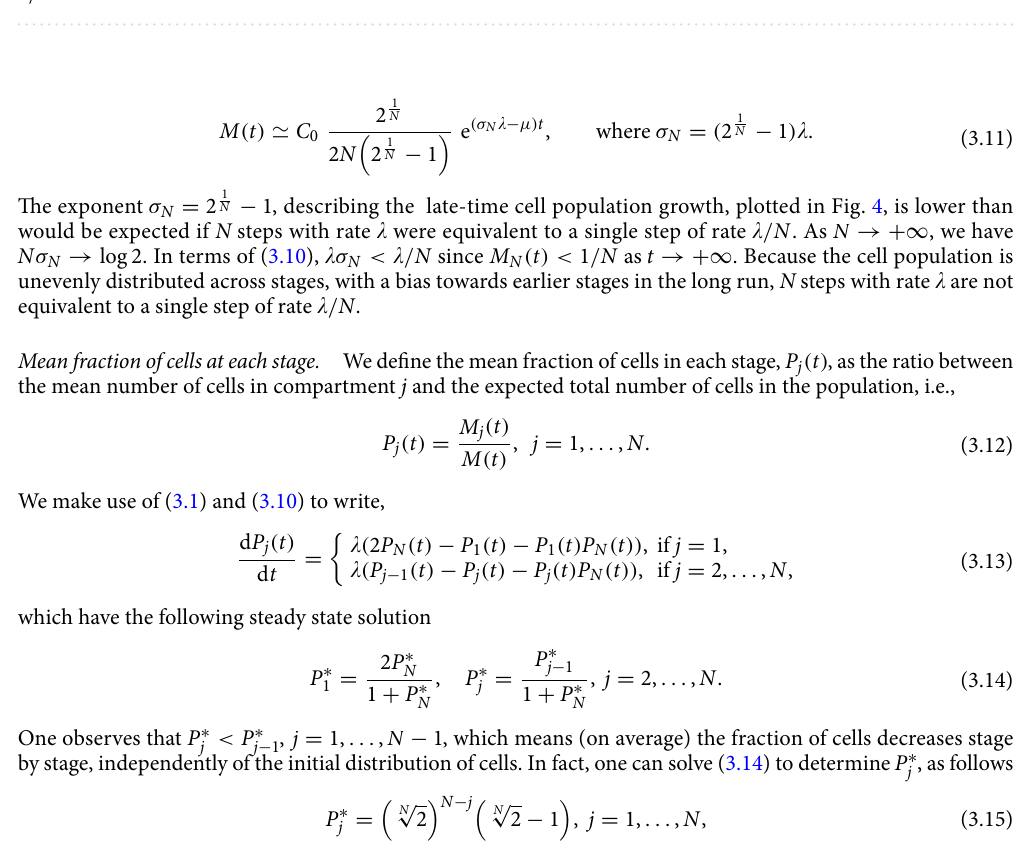
Figure 4. The exponent σ N that determines the asymptotic growth rate of the population is shown against the number of stages. The dotted line would be expected if N steps with rate (cid:31) were equivalent to a single step of rate (cid:31) / N